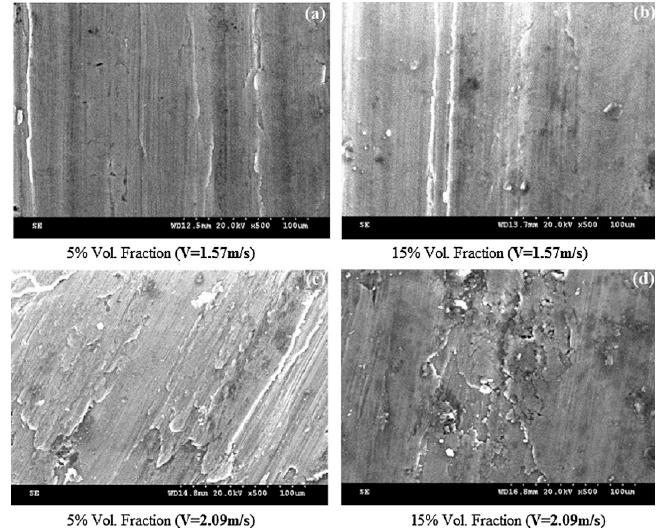
Figure 18. SEM photographs of the worn surface of different HMMCs. ( a ) Al/5% reinforcement composite at 1.57 m/s velocity, ( b ) Al/15% reinforcement composite at 1.57 m/s velocity, ( c ) Al/5% reinforcement composite at 2.09 m/s velocity, ( d ) Al/15% reinforcement composite at 2.09 m/s velocity